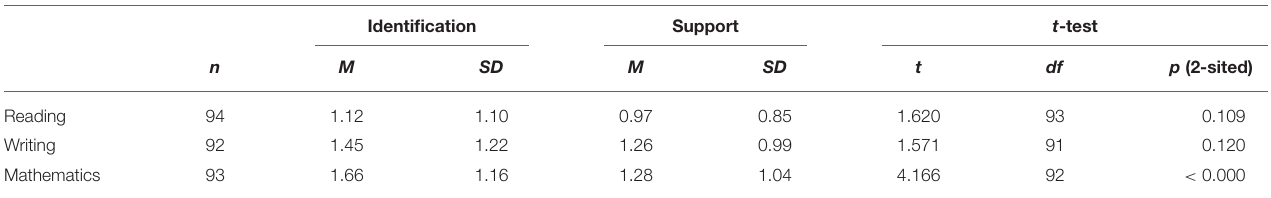
TABLE 7 | Differences between identification of difficulties and support of students with difficulties in reading, writing, and mathematics.